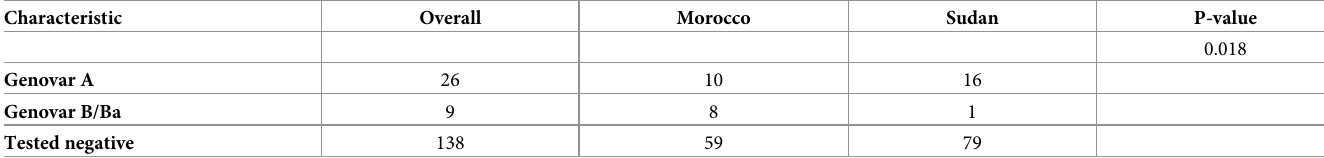
Table 3. Distributions of different C . trachomatis genovars among Sudanese and Moroccan children.